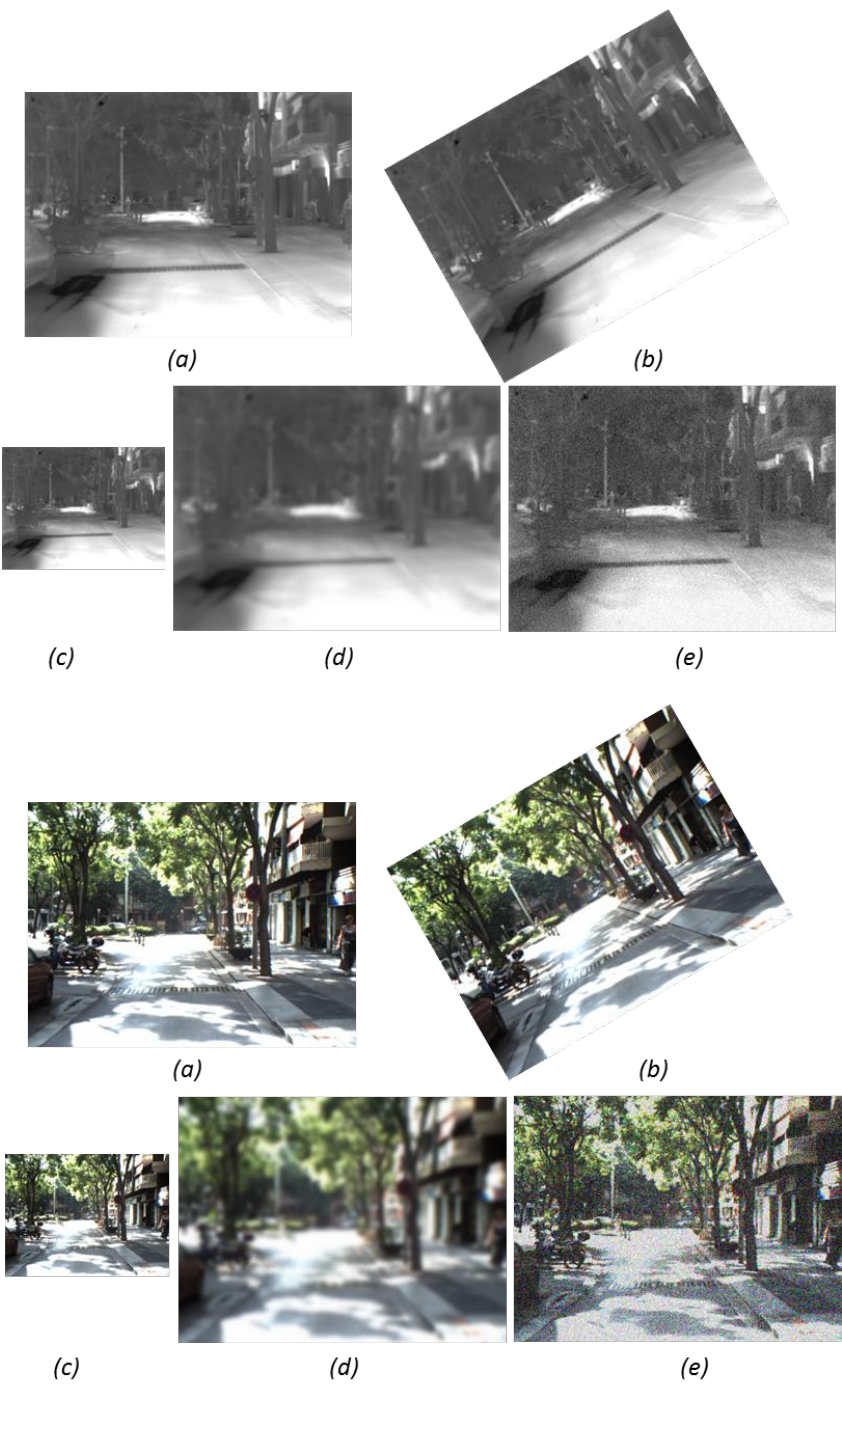
Figure 1. Illustration of a pair of images from the evaluation dataset (( top ) LWIR and ( bottom ) VS) together with their corresponding transformed images: ( a ) original ones; ( b ) rotation; ( c ) scale; ( d ) blur; ( e )